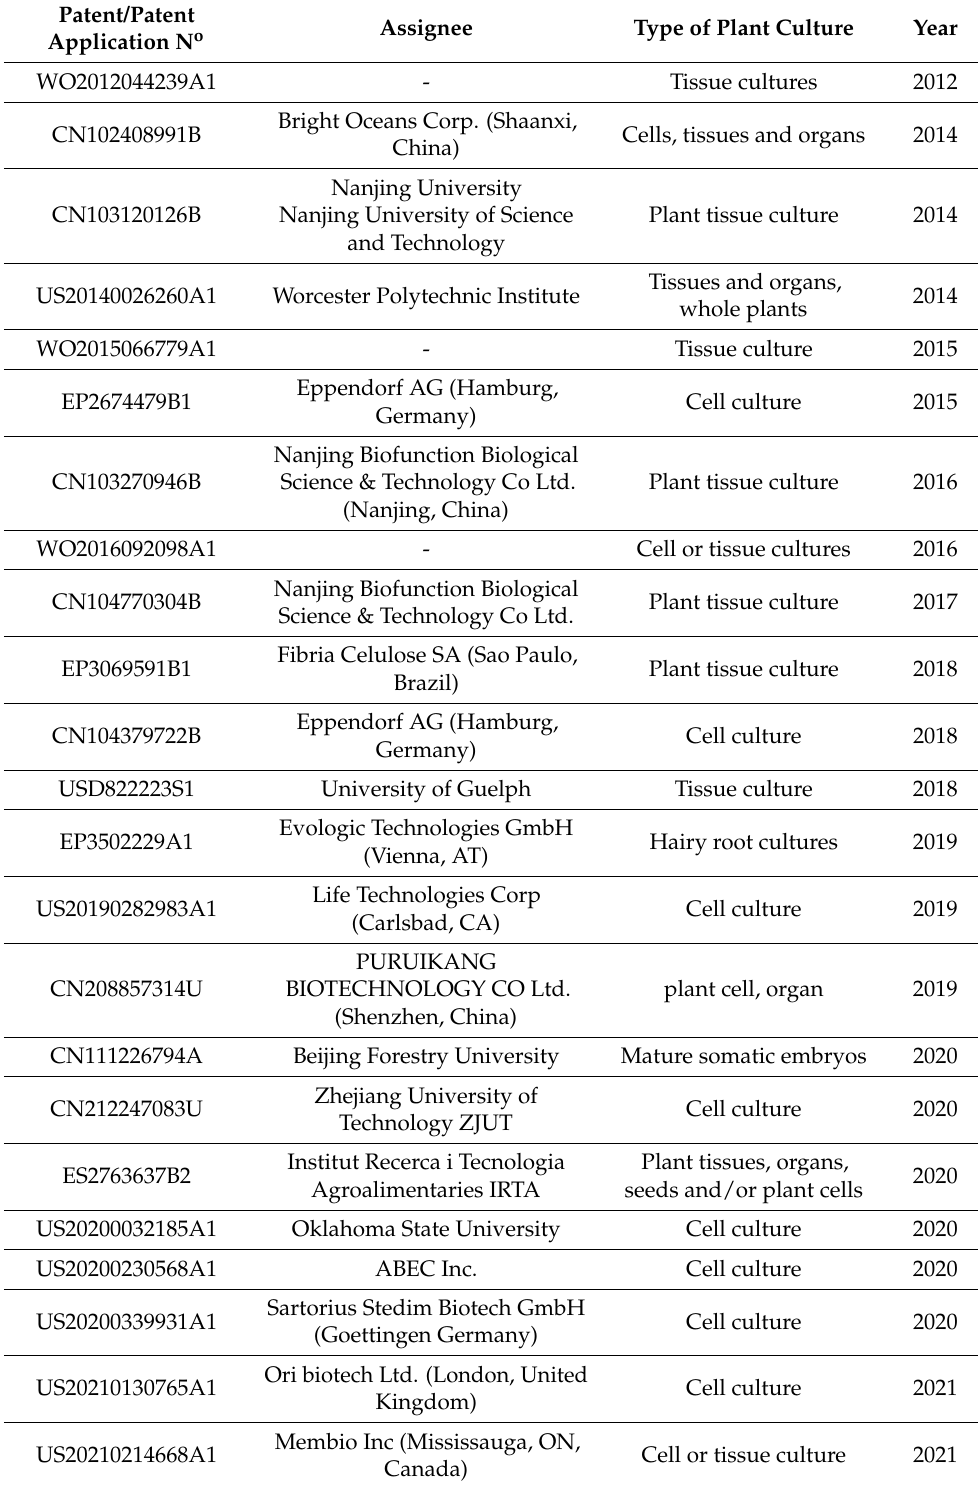
Table 3. Selected examples of patents relating to bioreactors for the culture of plant